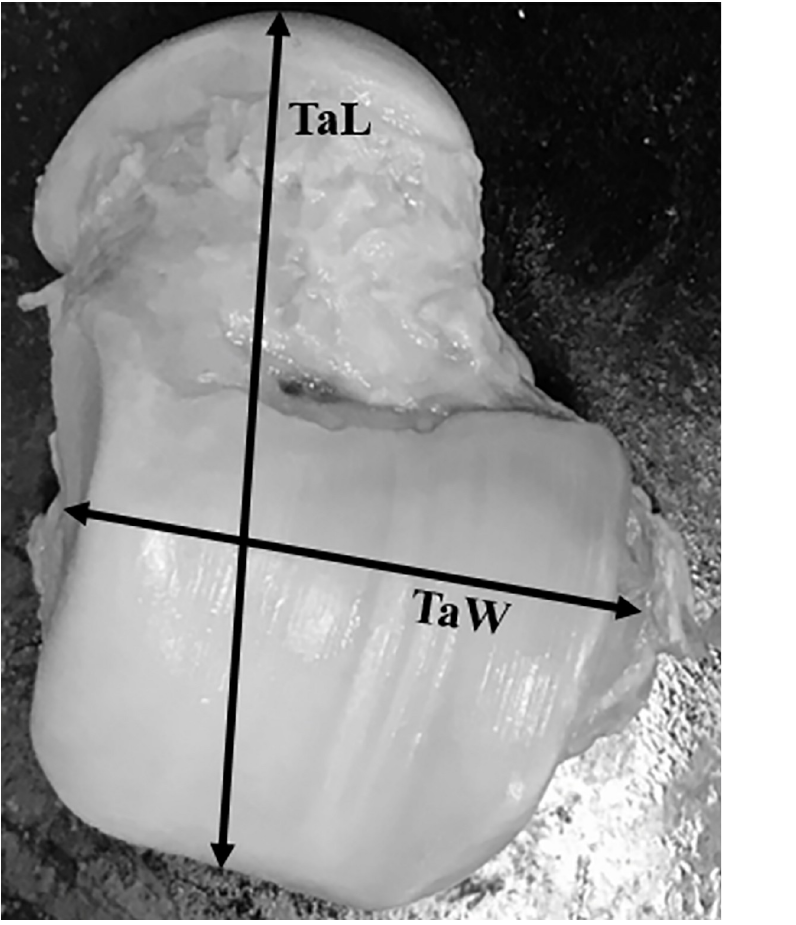
Fig 2. Abbreviations: Talar length (TaL); Talar body width